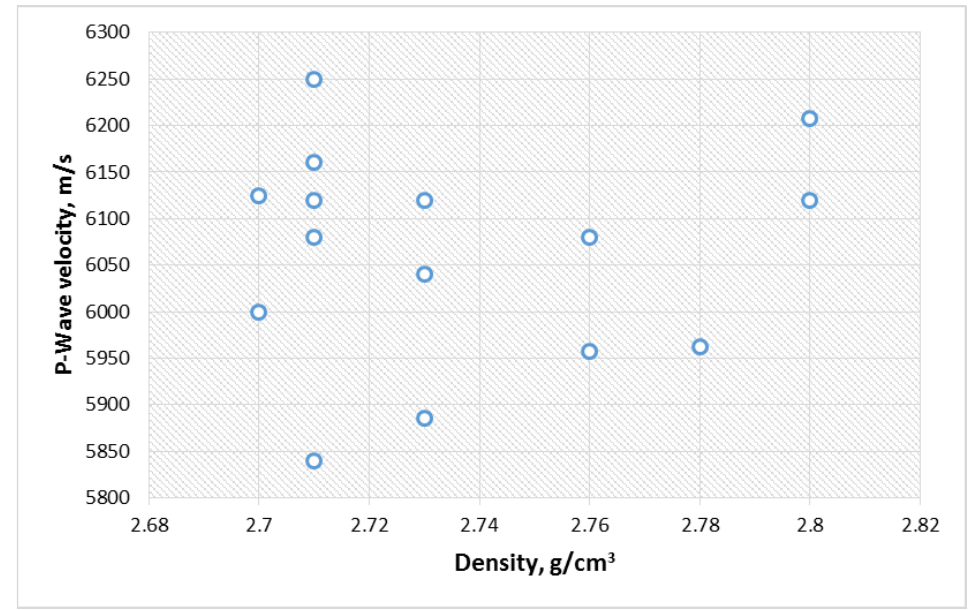
Figure 11. Correlation between P-wave velocity and density of the studied samples.